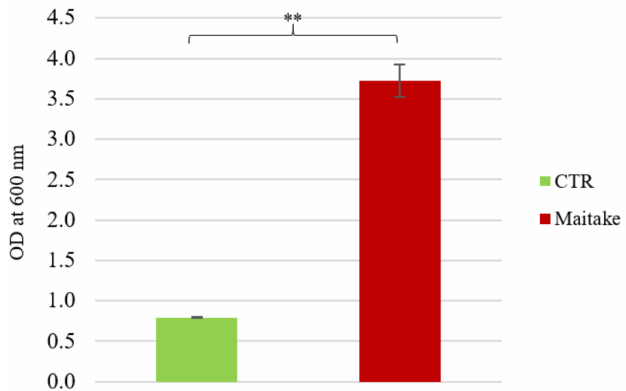
Figure 2. Prebiotic potential of Maitake extract on probiotic consortium. The figure represents the growth of consortium of the selected probiotic strains in presence of CTR medium and Maitake extract at a concentration of 2% w / v . Values are represented as mean value of OD at 600 nm ± standard deviation. Statistical differences were calculated using t -Student’s test: ** p -value < 0.01.